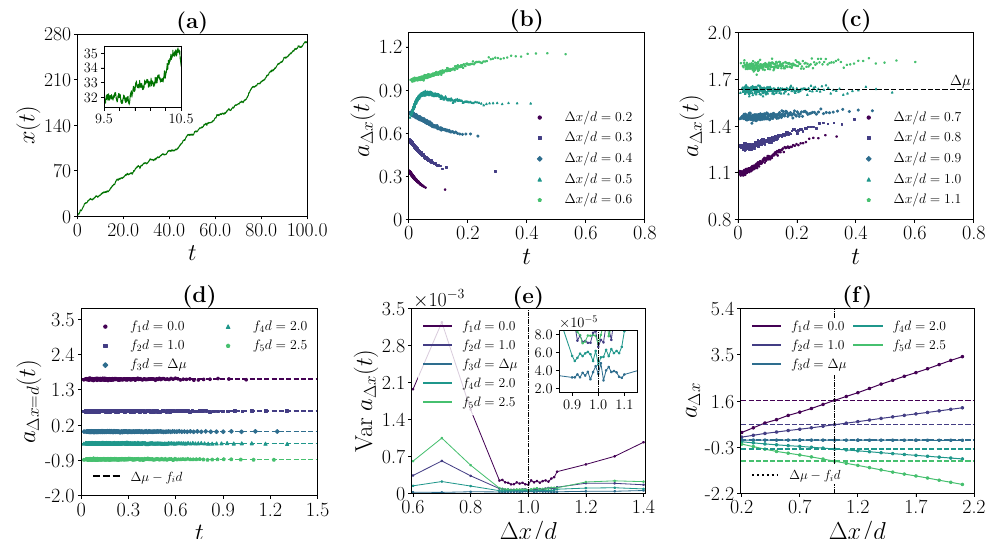
Figure 4. Inference of motor characteristics in the regime of weak coupling ( κ = 15 d − 2 , ∆ µ = 1.63). ( a ) Exemplary bead trajectory for fd = 0.0. For the chosen coupling strength, an identification of single motor steps along the trajectory is not possible. ( b , c ) a ∆ x ( t ) as a function of t for different ∆ x / d for fd = 0.0. ( d ) a ∆ ∆ x / d = 1.0 for different f . ( e ) Variance of a ∆ x ( t ) as a function of t at x ( t ) as a function of ∆ x / d for different f . ( f ) a ∆ x as a function of ∆ x / d for different f . For ( d – f ), the applied force f 3 is the stalling force of the motor. In ( e , f ), the black dash-dotted line corresponds to ∆ x / d =